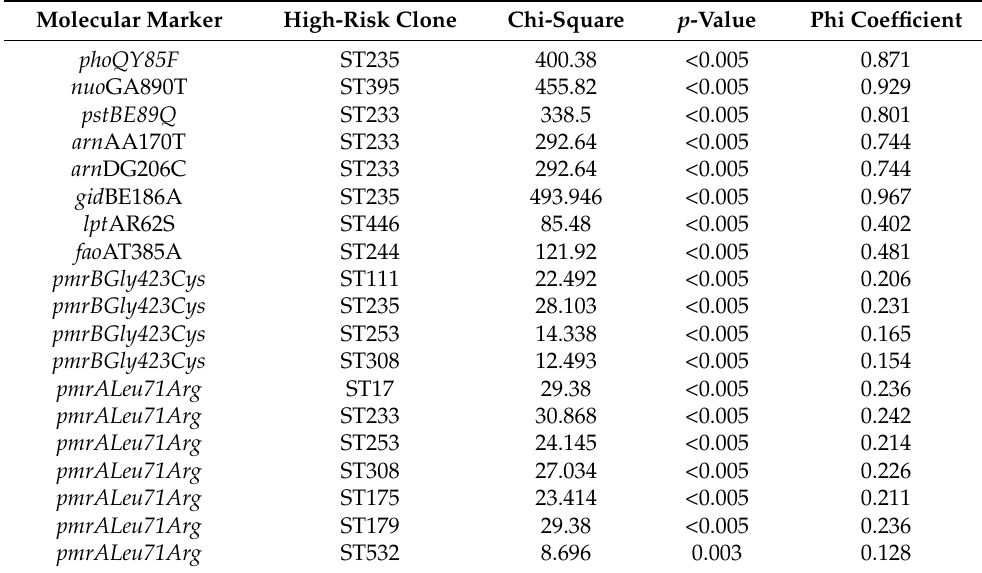
Table 3. Amikacin molecular markers showing significant associations with specific high-risk